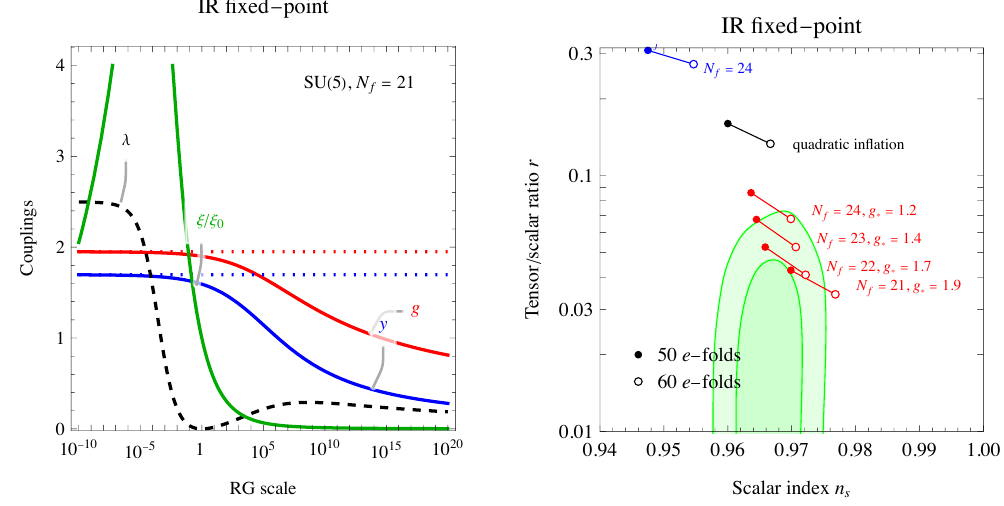
Figure 4 . Inflation with couplings that approach a fixed point in the IR. Left : sample of RG running in the model of section 4.4 for N its small-field (red) and large-field (blue) inflationary predictions for different values of N